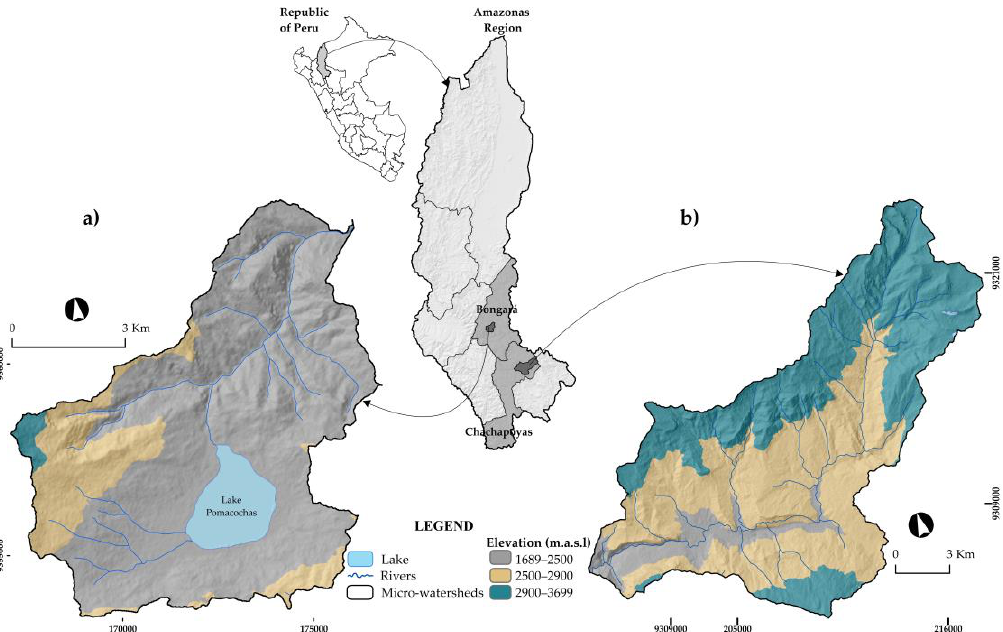
Figure 1. Location of the study area in the Amazon region: ( a ) the Pomacochas micro-watershed in the province of Bongará and ( b ) the Ventilla micro-watershed in the province of Chachapoyas.